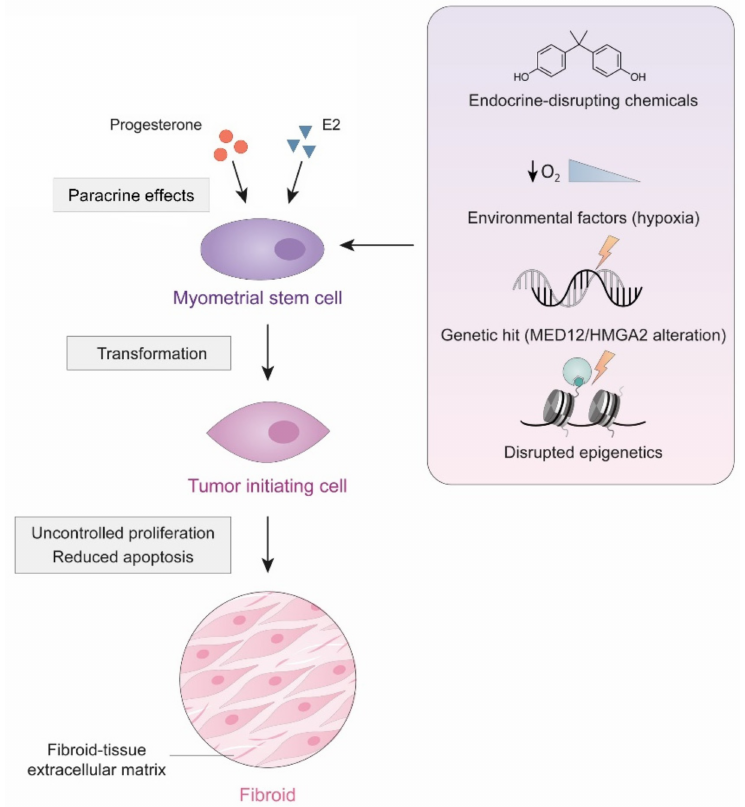
Figure 3. Cellular origin of uLM. Specific environmental and genetic changes may cause the transfor- mation of myometrial stem cells into tumor initiating cells, that, through uncontrolled proliferation and reduced apoptosis, may eventually give rise to a uLM